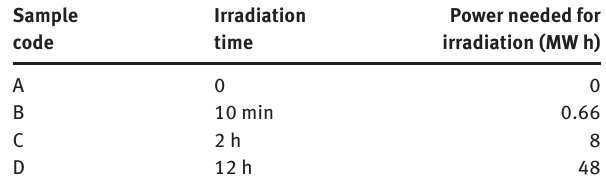
Table 3: Neutron absorption cross-sections for thermal neutrons of various elements.